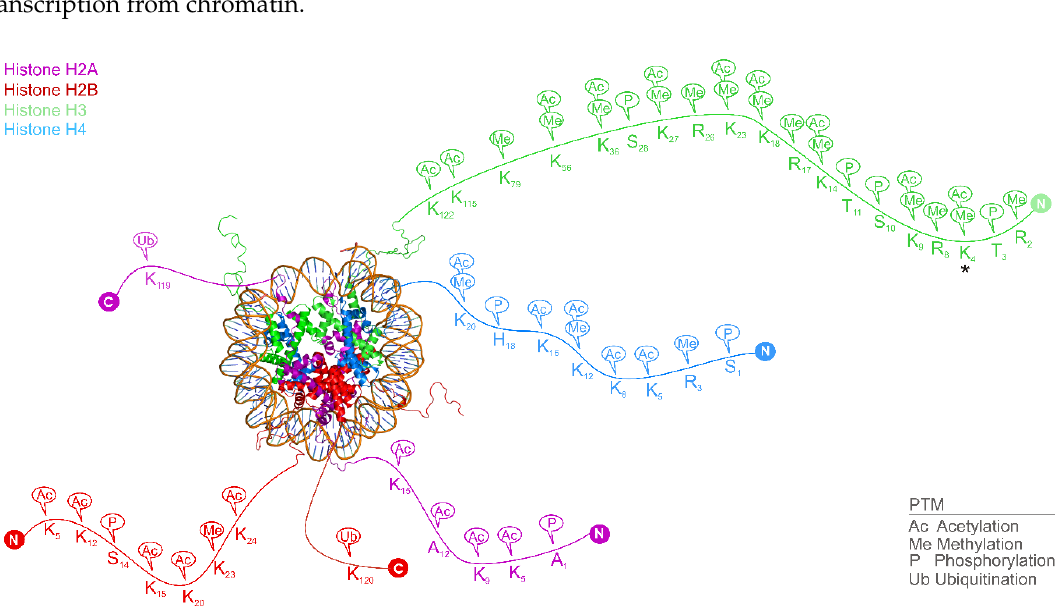
Figure 2. The three-dimensional structure of a nucleosome combined with a schematic representation of post-translational modifications (PTMs) on the histone tails assembled from recent articles [31,36–46]. The nucleosome structure was rendered in top view by PyMol [47] using PDB structure 1kx5 [48]. Histone proteins are shown in cartoon representation as wrapped by the DNA double helix. The N- and C-terminal tails of histone proteins pass through the cylinder of the supercoiled DNA and are available for reader proteins recognizing the PTMs, key components of the histone code system. Different histone PTMs play various roles in normal physiology and disease pathomechanisms. PTMs